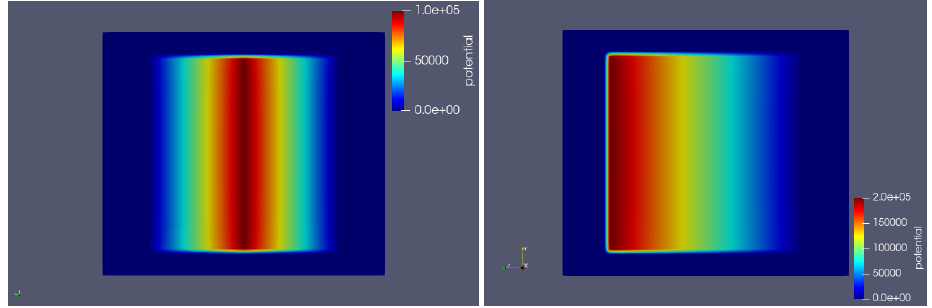
Figure 7. ( Left ): Voltage profile for the dual-anode design. ( Right ): Voltage profile for single-anode design. Voltage and field plots drawn on the central axis of the TPC and across the insulation gap are also available in Appendices B and